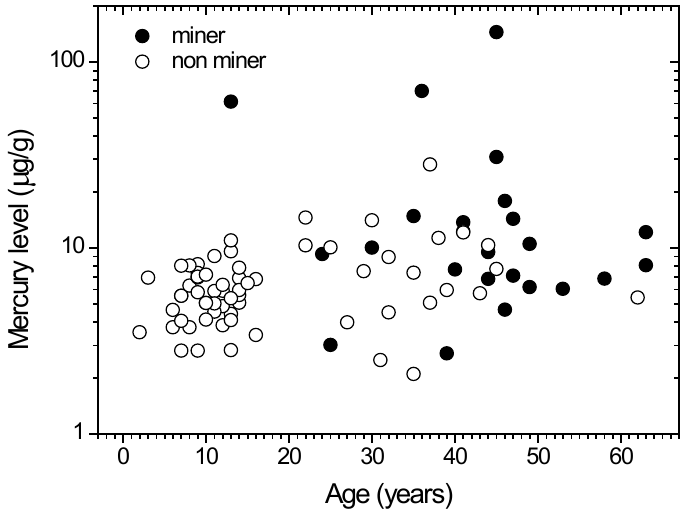
Figure 3. Distribution of mercury level among population of Gorontalo utara Regency. Open ( ○ ) and closed ( ● ) symbols denoted for non miner and miner groups, respectively.